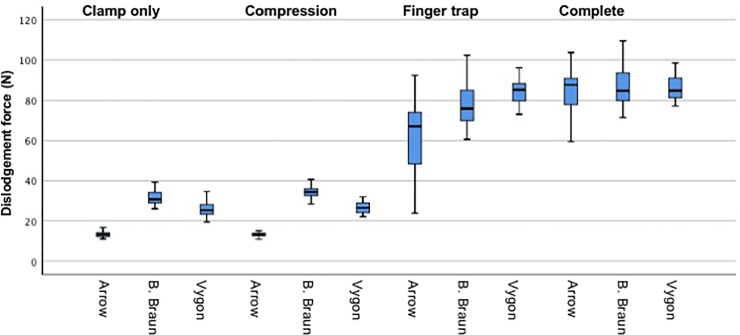
Dislodgement forces.Dislodgement forces measured in Newton (N). The boxes represent median, 25% and 75% quantile. The whiskers represent 1.5 x interquartile range. 300 test runs were performed in total, 25 test runs were performed in each experimental group.